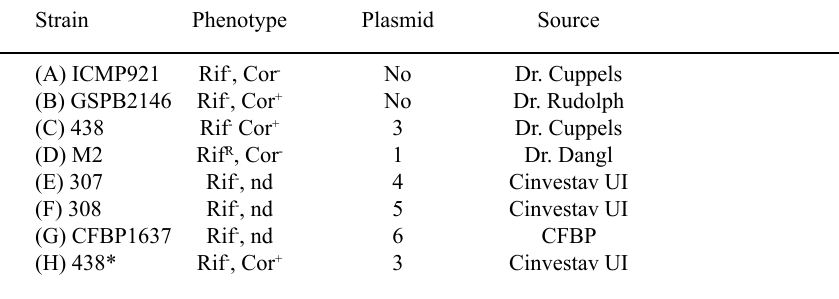
table 1. Strains used in this work. Strain Psm 438 was used twice, but from different sources